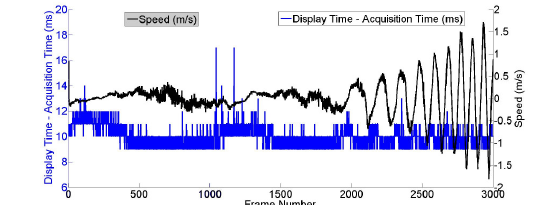
Figure 13: Evaluation of the difference of time between image acquisition and segment display while varying the speed of the hand movement.